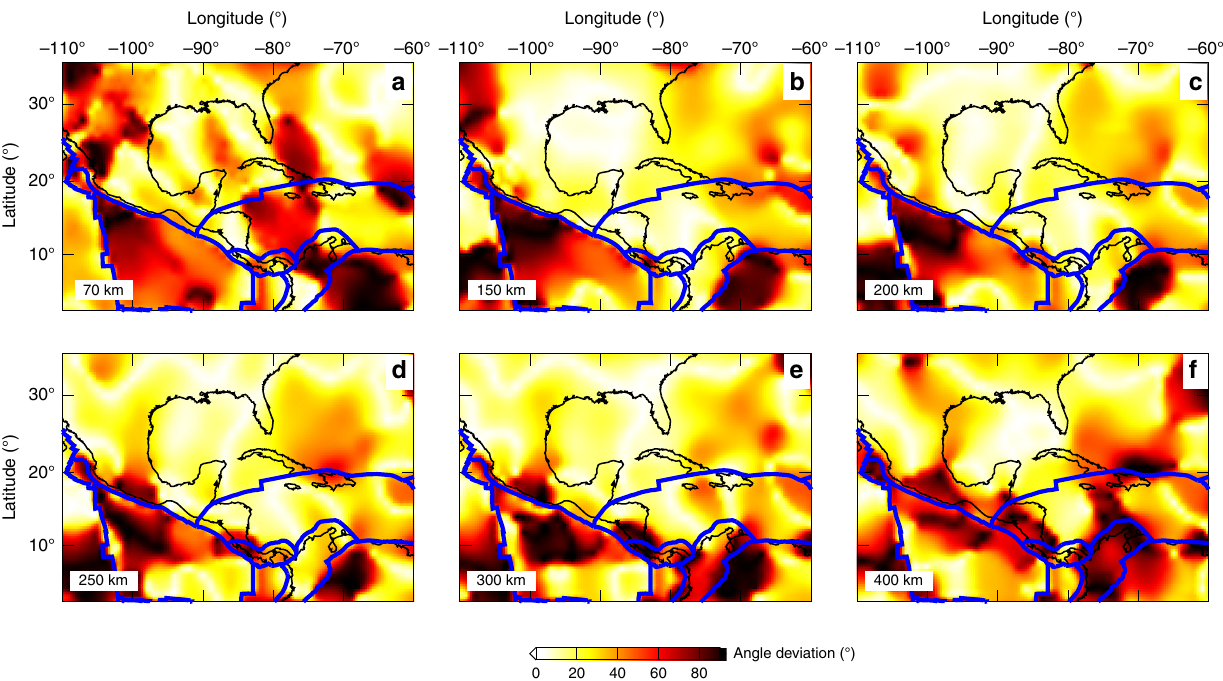
Fig. 8 Angle differences between the fast axis orientations in model US 32 and the plate motion model NUVEL-1A 58 with the hotspot reference frame. a – f Results at depths ranging from 70 to 400 km, with warm color representing large angle differences. Blue lines denote the plate boundaries 87